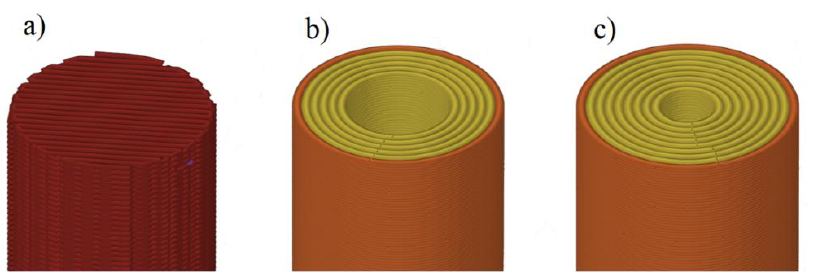
Figure 7. Checking layer formation, ( a ) 0 contour lines and 100% infill with X formation, ( b ) six contour lines and ( c ) nine contour lines.